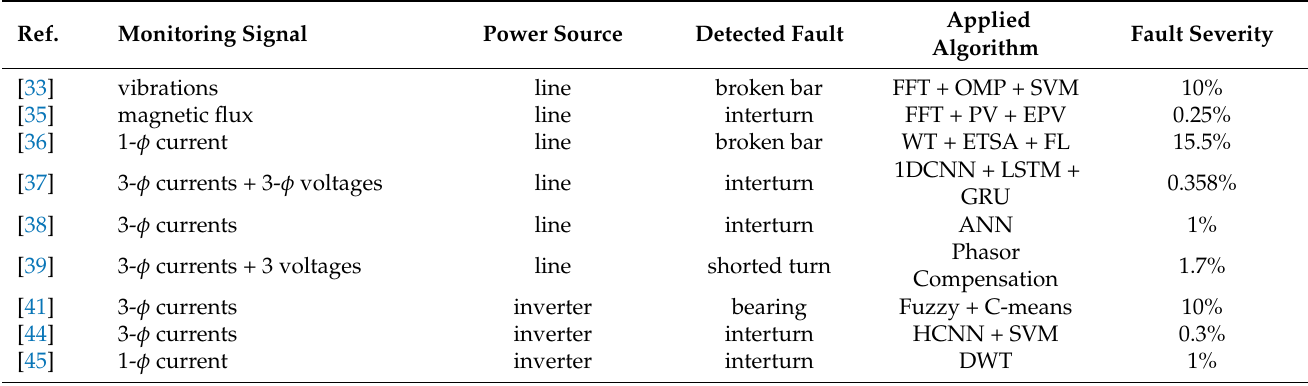
Table 2. Comparison of early fault detection methodologies applied on IM under steady regime.